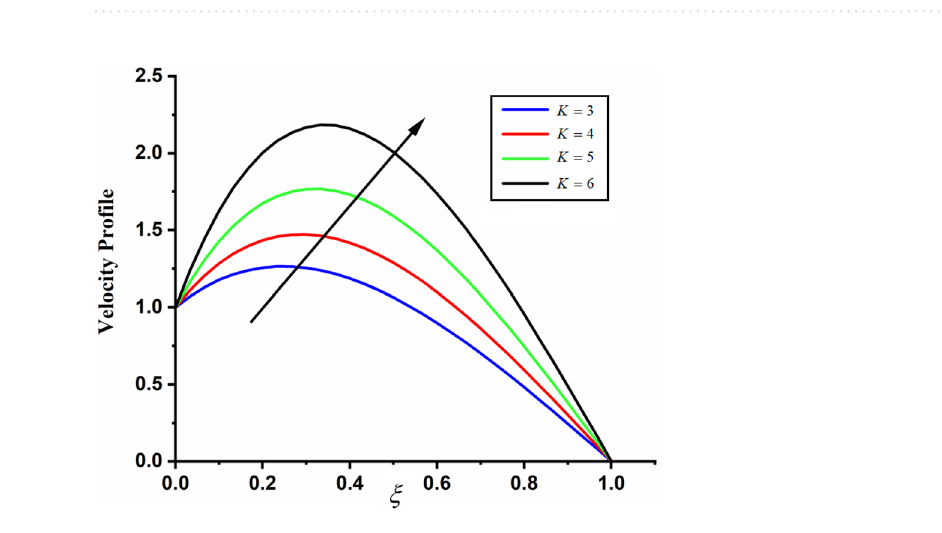
Figure 8. The impact of K on fractal-fractional couple stress fluid velocity in channel when, α = 0.5 , β = 0.5 , Gr = 2 , Gm = 3 , M = 2 , η A = 1 , P = 1.5 , Pr = 1.5 , Re = 2.5 and Sc = 0.3